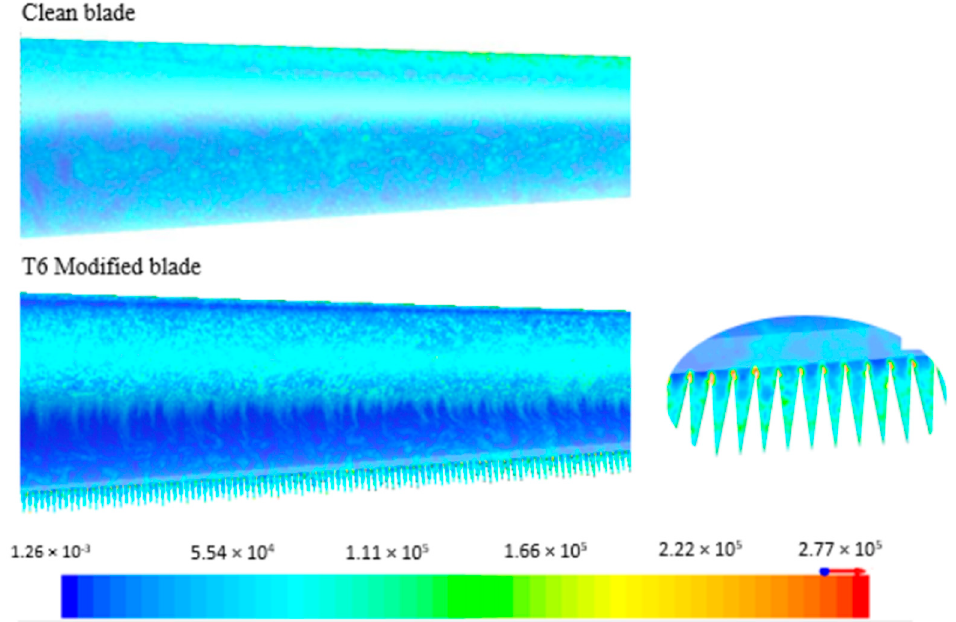
Figure 12. Vorticity core region with level 0.15 at V = 10 m/s .